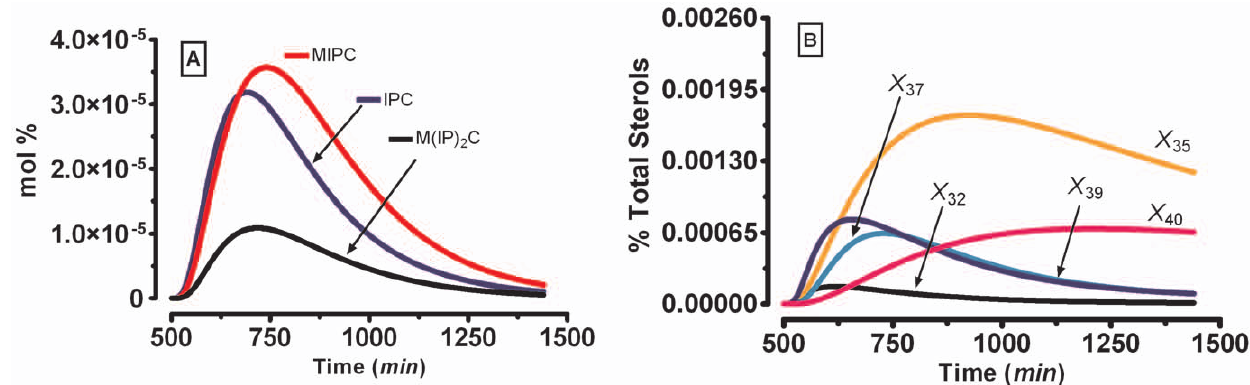
Figure 4. SL-E model results for an external pulse-chase bolus similar to the one in Fig. 3F. ( A ) Complex sphingolipids : Golgi compartment plus plasma membrane IPC ( X 8 + X 20 ), Golgi compartment plus plasma membrane MIPC ( X 18 + X 21 ), Golgi compartment plus plasma membrane M(IP) 2 C ( X 19 + X 22 ). ( B ) Ergosterol sub-populations : ergosterol in endoplasmic reticulum ( X 32 ), ergosterol steryl-ester-1 ( X 35 ), ergosterol associated with the complex sphingolipids ( X 37 ), plasma membrane ergosterol in inner leaflet ( X 39 ), ergosterol steryl-ester-2 ( X 40 ).